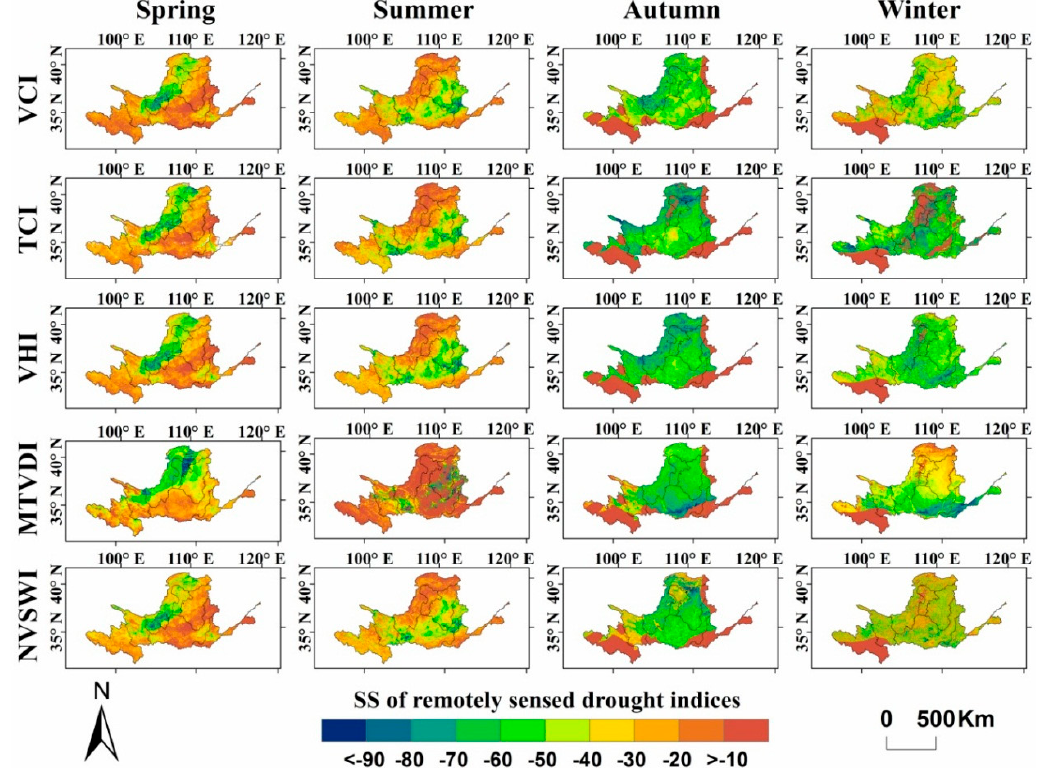
Figure 9. Spatial distribution of Skill Score (SS) in the Yellow River basin (YRB).